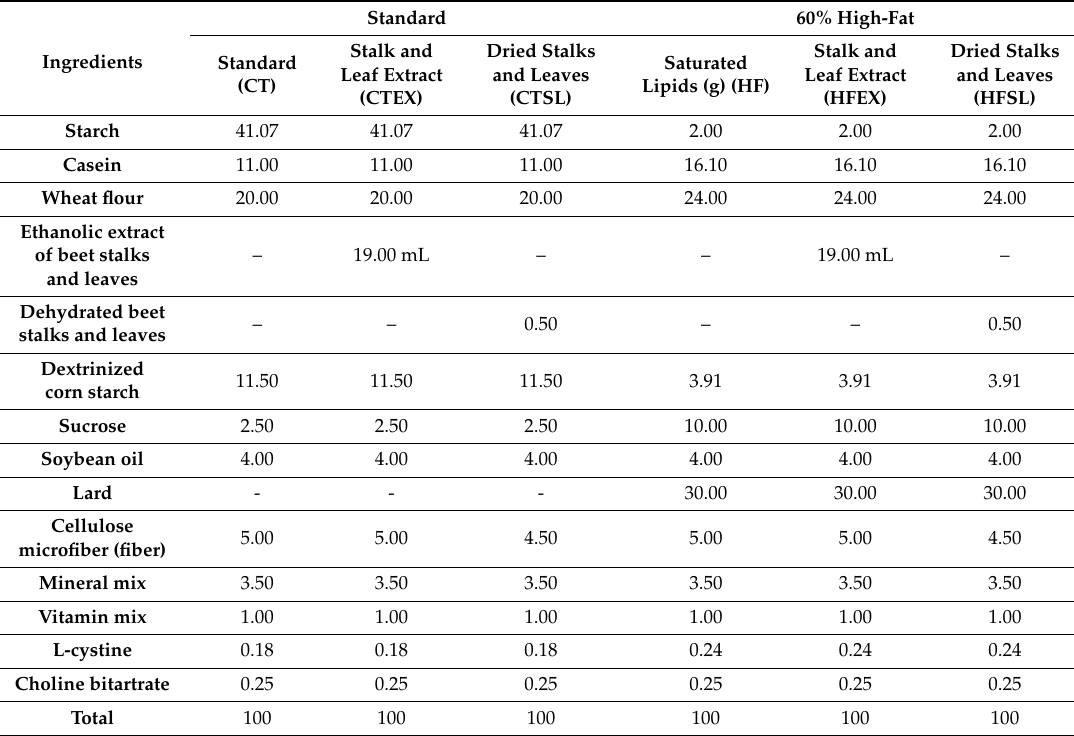
Table 2. Ingredient compositions of the control and high-fat diets (g · 100g − 1